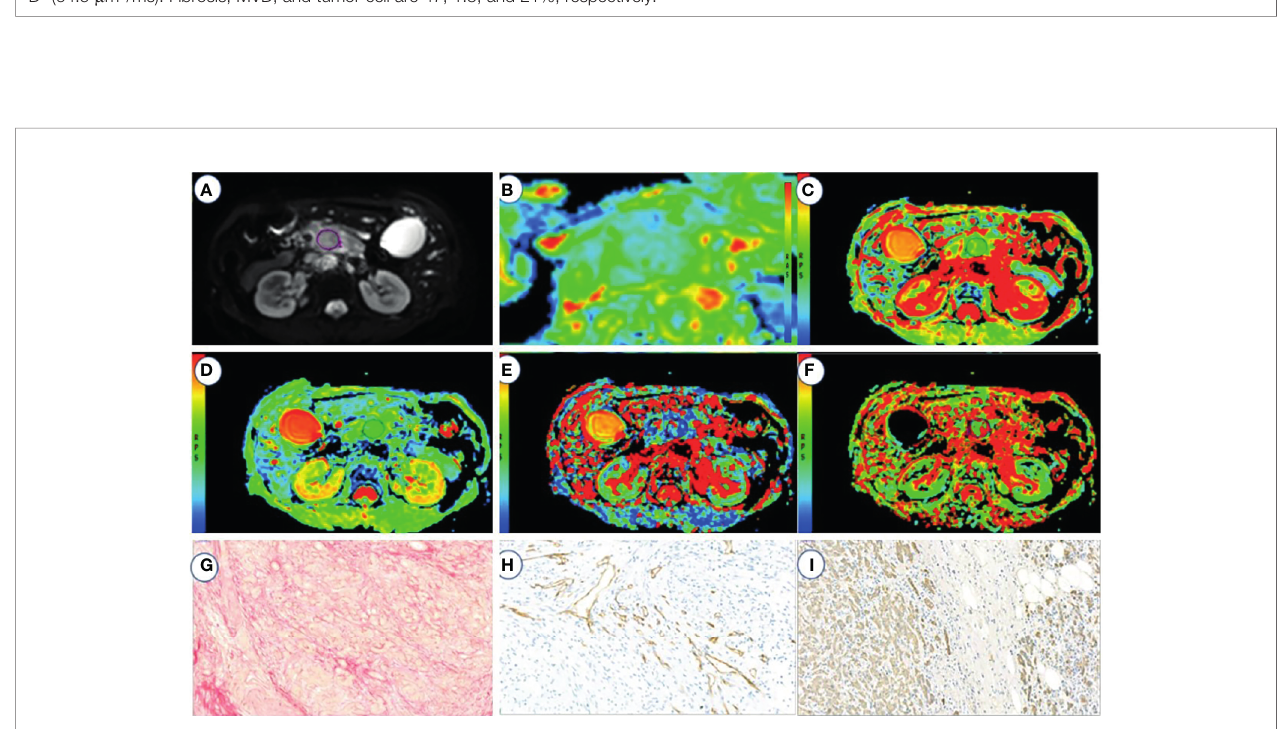
FIGURE 3 | A 72-year-old male with high fi brosis PDAC. (A – F) represents the DWI, ADC(0,500), ADC(0,800), D, f, and D* values map, respectively. (G – I) represents the fi brosis, microvascular density, and tumor cell dyeing map, respectively. ROI was set in PDAC on DWI, ADC (0, 500) , ADC (0, 800) , D, f, and D* values maps. The cancer tissue showed different signals from normal tissues in the DWI, ADC (0,500) (1.7 m m 2 /ms), ADC (0,800) (1.6 m m 2 /ms), D (1.53 m m 2 /ms), f (13.05%), and D* (125.3 m m 2 /ms). Fibrosis, MVD, and tumor cell are 21, 6.5, and 29%,